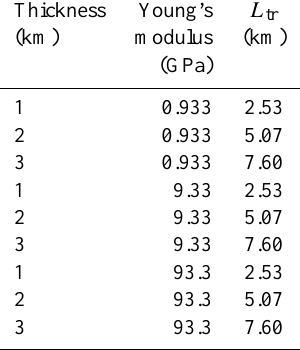
Table 4. L tr for 2-D models with a zero-displacement basal condi- tion. Note that L tr values are linear with thickness and independent of Young’s modulus. Thickness